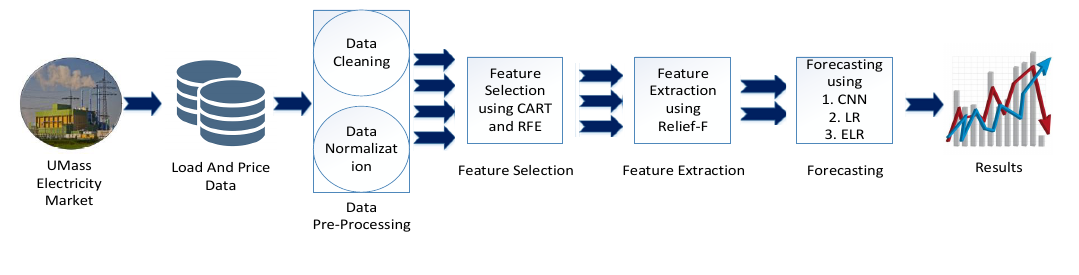
Figure 3. Proposed system model